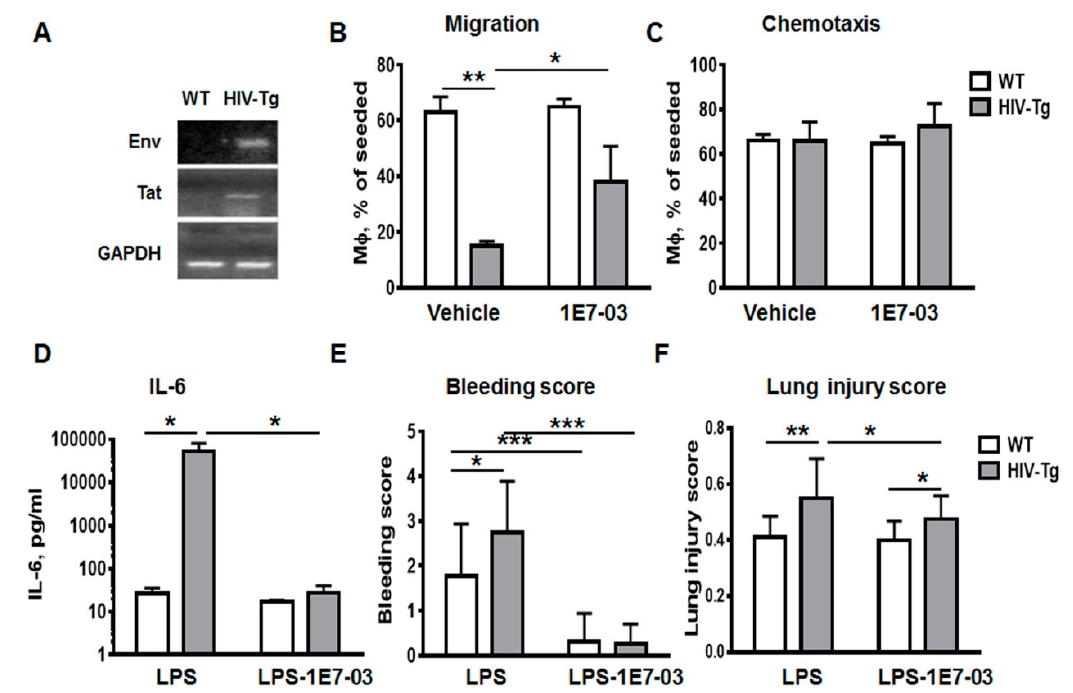
Figure 6. Administration of HIV transcription inhibitor improves migration of macrophages in vitro and reduces lung injury in HIV-Tg mice. ( A ) Real-time polymerase chain reaction (RT-PCR) for HIV-1 env and tat genes in the peritoneal macrophages isolated from WT and HIV-Tg mice. (B and C) Trans-endothelial migration ( B ) and chemotaxis ( C ) of peritoneal macrophages isolated from WT and HIV-Tg mice. 1E7-03 HIV-1 transcriptional inhibitor (1 µ M) or 10% dimethyl sulfoxide (DMSO, vehicle) were added to macrophages. ( D – F ) Administration of 1E7-03 in HIV-Tg mice (1 µ g / mg of body weight) significantly reduced levels of circulating IL-6 ( C ), bleeding score ( D ) and lung injury score ( E ). Asterisks indicate: * p < 0.05; ** p < 0.01 and *** p < 0.005.